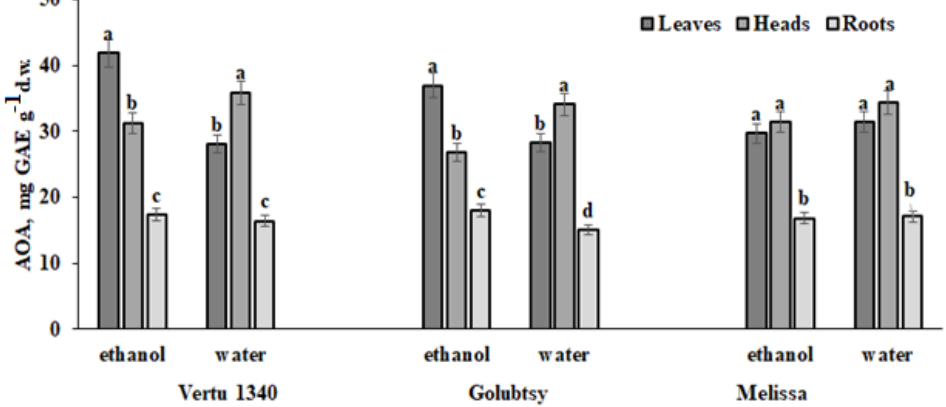
Figure 7. Mean AOA values for water and ethanol soluble antioxidants in leaves, head, and roots of the Savoy cabbage subjected to Se and Chlorella treatment without the data related to control plants. Within each cultivar, values with the same letters do not differ significantly according to the Duncan test at p < 0.05. Table 4. Hydrophobic and hydrophilic extract antioxidant activity of the Savoy cabbage subjected to Se and Chlorella treatment (mg GAE g − 1 d.w.).